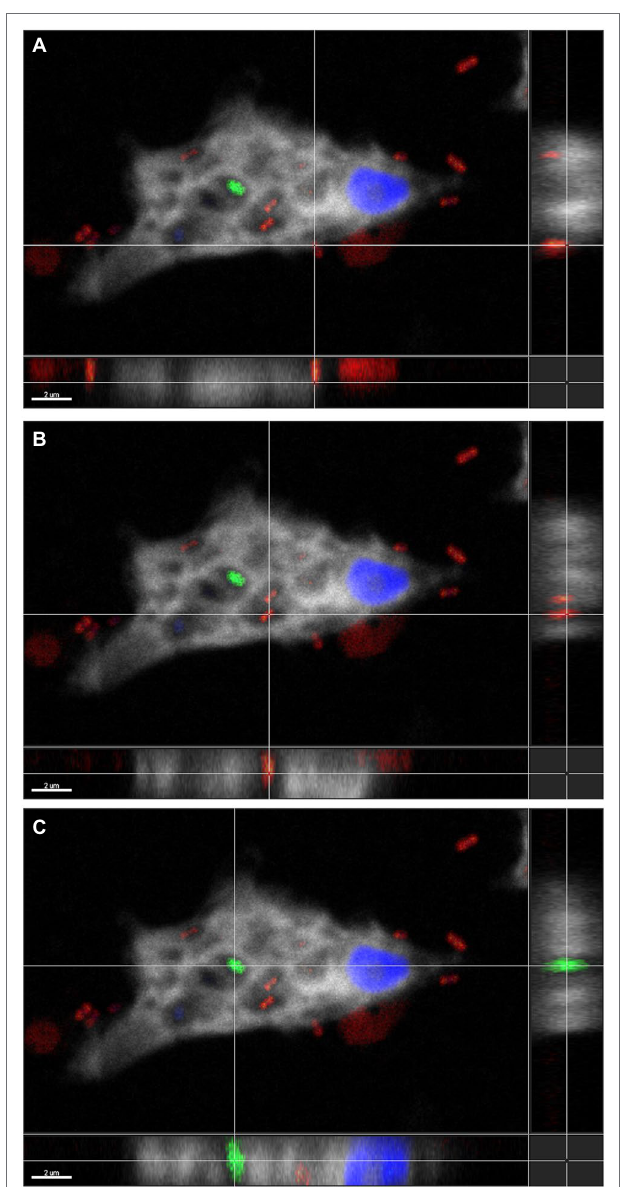
FIGURE 5 | Three-dimensional FISH analysis of D . terrae strain Ely Copper Mine inside Stemonitis sp. FISH microscopy images were analyzed in-depth to determine the extracellular (panel A ) and the intracellular (panel B ) location of Dyella (in red) and other bacteria (in green, panel C ). The margin images underneath and to the right of panels (A-C) represent projections through x-y and z planes, respectively. The colors white and blue correspond to the cy5 probe against Stemonitis and DAPI, respectively. The bar length represents 2 µm for all